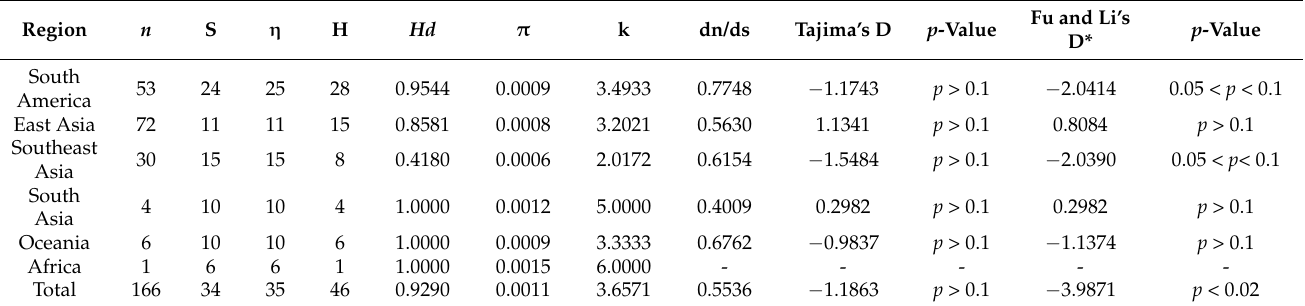
Table 4. Estimates of the number of isolates and SNPs, nucleotide diversity, haplotype diversity and neutrality indices of pvmrp1 .